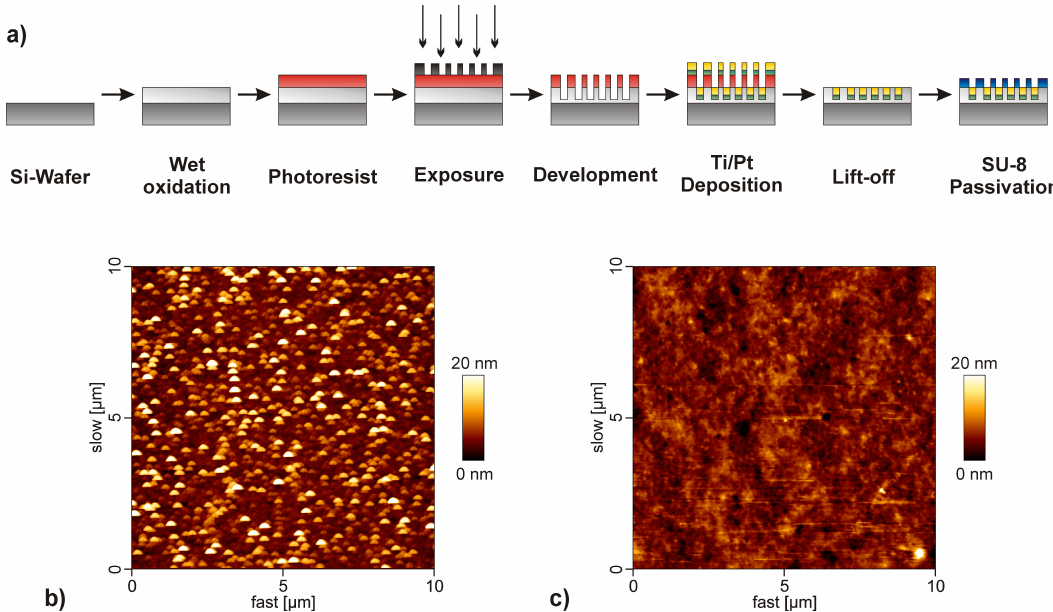
Figure 1. ( a ) Schematic process flow for fabrication of the silicon-based multi-analyte biosensor chip. Atomic force microscopy images (10 × 10 µ m 2 ) of ( b ) the blank platinum electrode and ( c ) the sensor surface after immobilization of D -lactate dehydrogenase ( D -LDH) and diaphorase